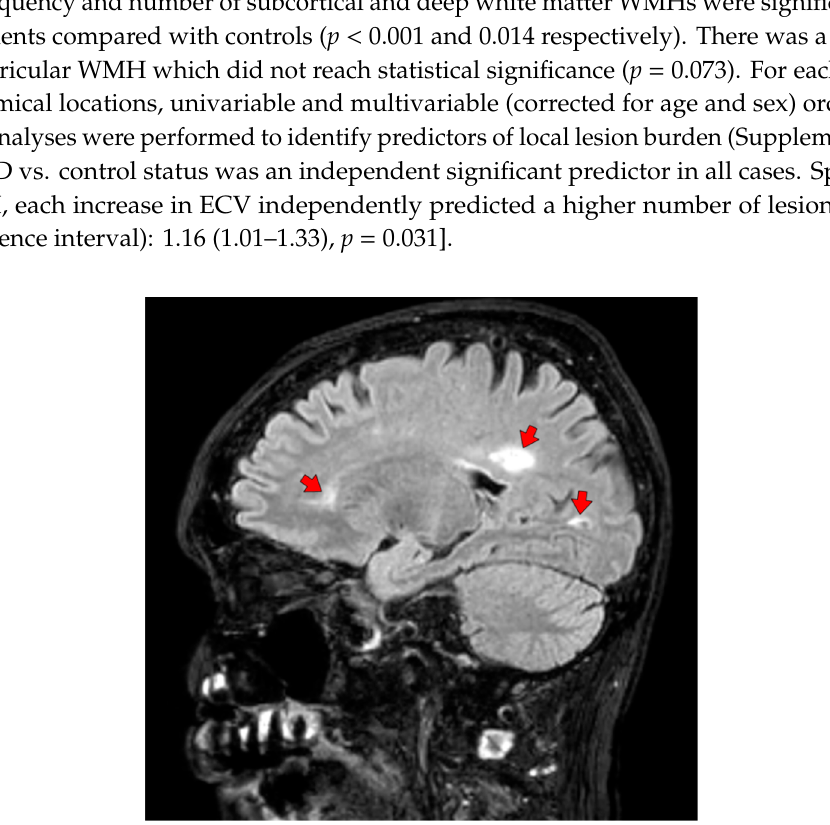
Table 2 .Baseline characteristics compared between patients with and without identified brain lesions.